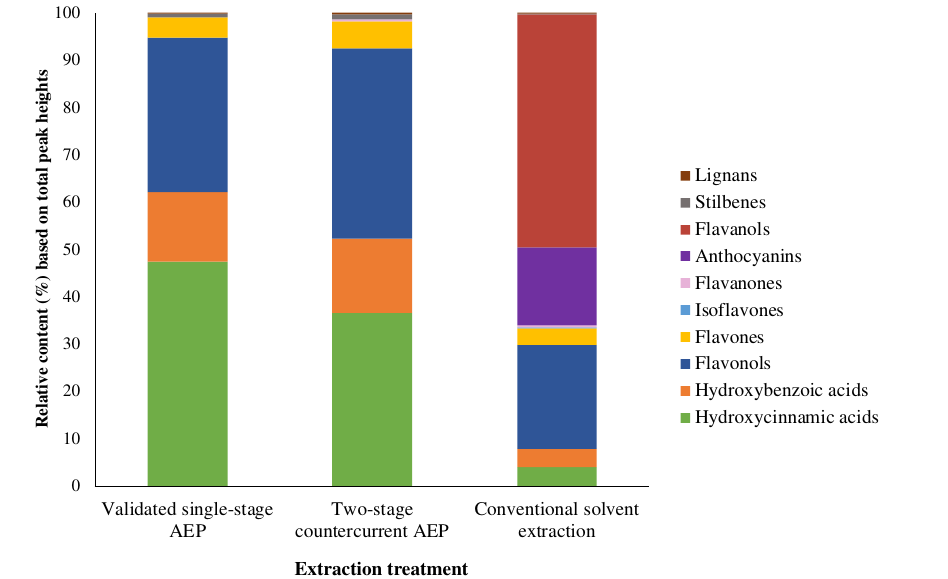
Figure 6. Phenolic composition of validated single-stage AEP, two-stage countercurrent AEP, and con- ventional solvent extracts as identified by untargeted